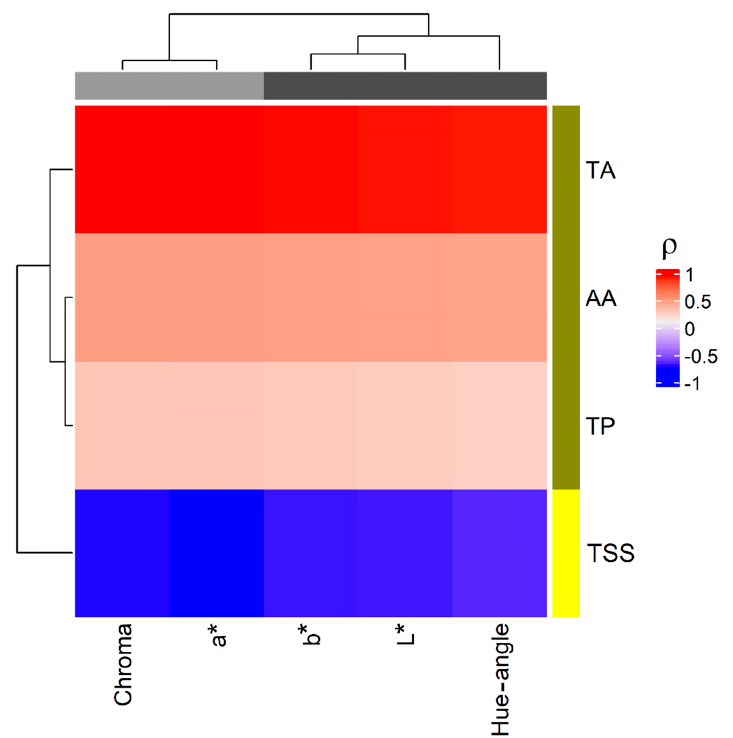
Figure 7. Correlations between image data and chemical data: heatmap; a different colour code was used to represent the clusters discovered by cluster analysis; ρ is the Pearson correlation coefficient.